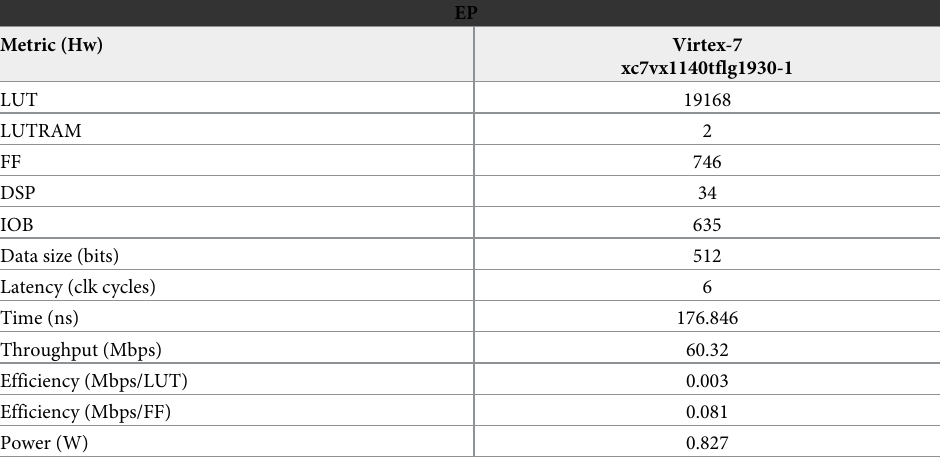
Table 8. Implementation results for the EP-based hardware